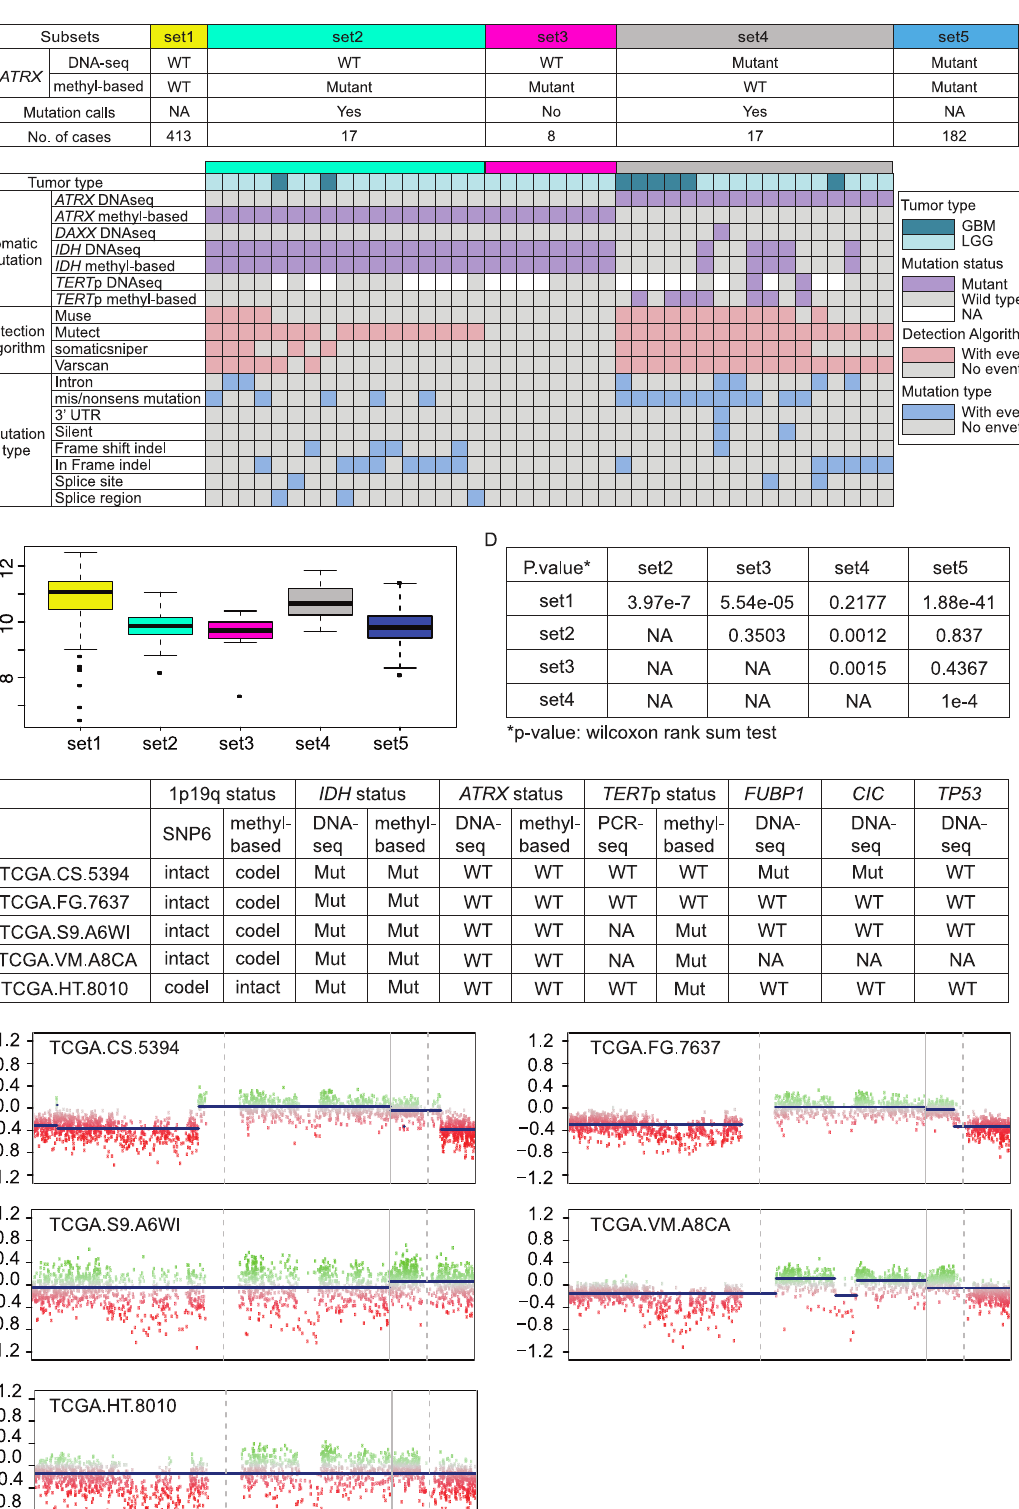
icytoma) samples are expected to have a euploid genome while